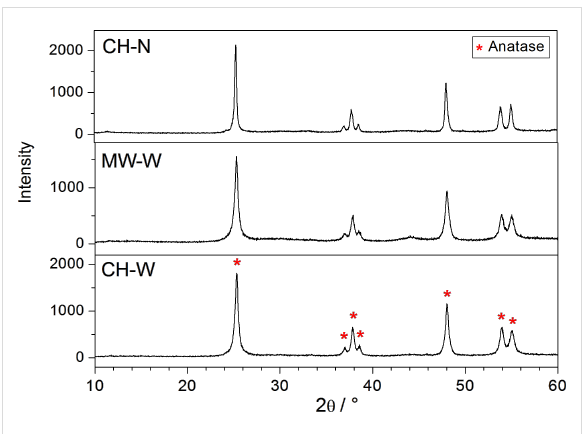
Figure 3: XRD patterns of TiO 2 nanoribbons derived from hydrogen titanate nanoribbons in water in a hydrothermal reactor ( CH-W ), a mi- crowave reactor ( MW-W ), and in 0.5 M NH 3 (aq) in a hydrothermal reactor ( CH-N